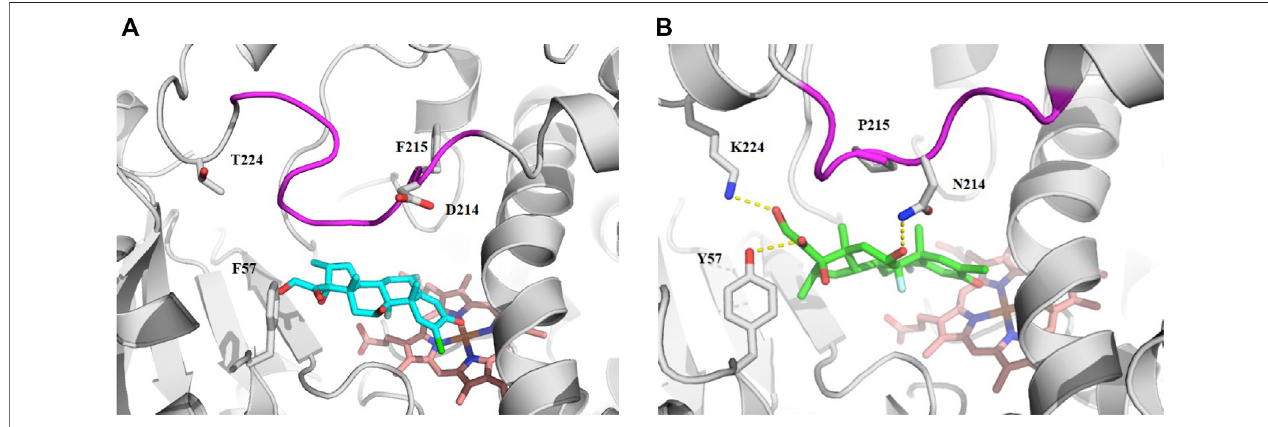
FIGURE 5 | The predicted binding mode of halometasone in the active cavity of CYP3A4 (A) and CYP3A7 (B) . Key residues interacting with the bound substrate are shown as sticks and H-bonding interactions are shown with dotted line. The fl exible FG loop is shown in magenta and the heme group is shown in orange.